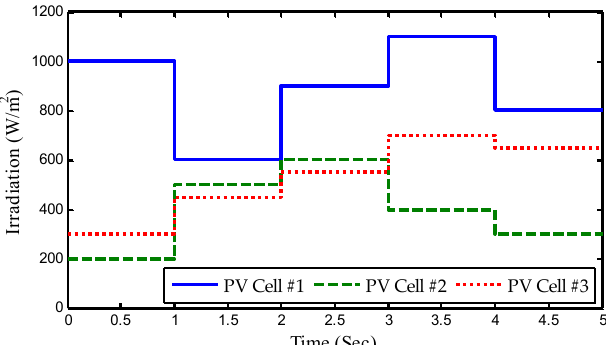
Figure 6. Step change of solar irradiation with PSC. PSC: Partial Shading Conditions.